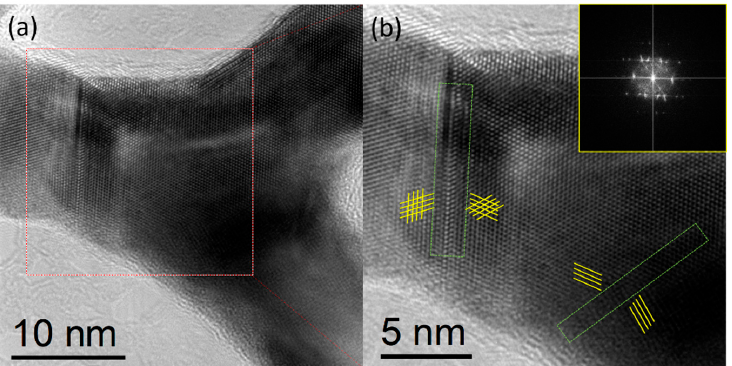
Figure 2. ( a ) SEM, ( b , c ) TEM, ( d ) enlarged HRTEM image of the green part in c, and ( e ) relative elemental mappings of AuCu.